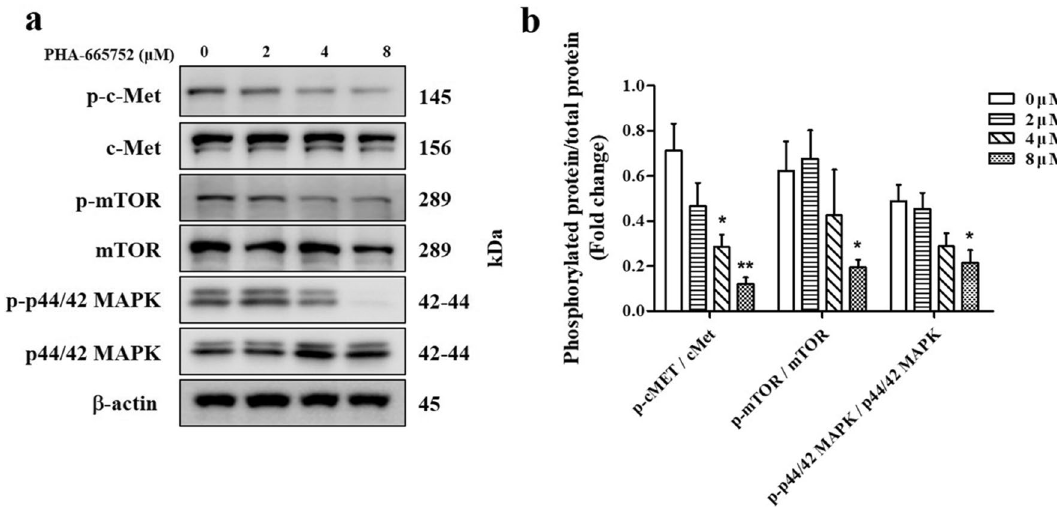
Figure 2. Inhibition of the HGF/c-Met signaling pathway in keloid fibroblasts treated with PHA-665752. ( a ) Western blot of expression of p-c-Met, p-mTOR, and p-p44/42 MAPK in keloid fibroblasts treated with the indicated concentration of PHA-665752. Full-length blot images are presented in Supplementary Fig. 3a. ( b ) Relative protein levels (*represents p < 0.05, **represents p < 0.005).